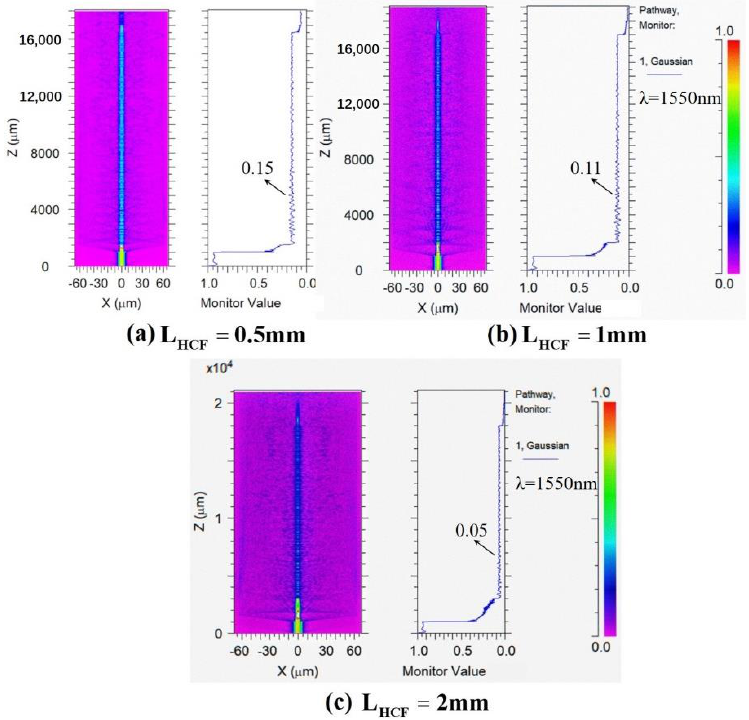
Figure 3. ( a ) – ( c ) Light-field distribution simulation with different HCF lengths. Figure 3. ( a – c ) Light-field distribution simulation with different HCF